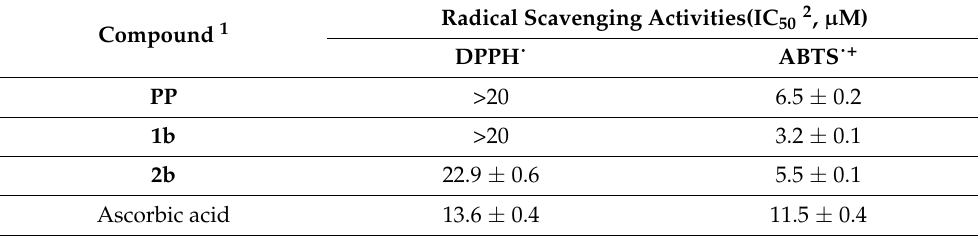
Table 4. In vitroantioxidant activity of the test compounds. IC 50 (concentration of a compound reducing radical concentration by 50%) values are mean ± SD of triplicates. Compound